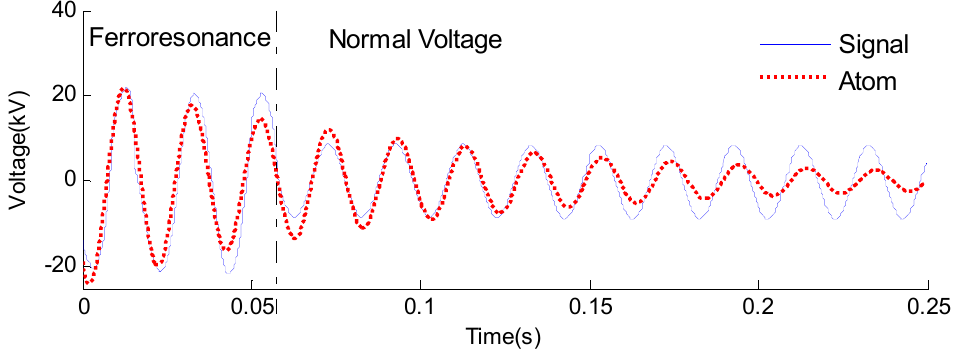
Figure 2. An incorrect decomposition result of time